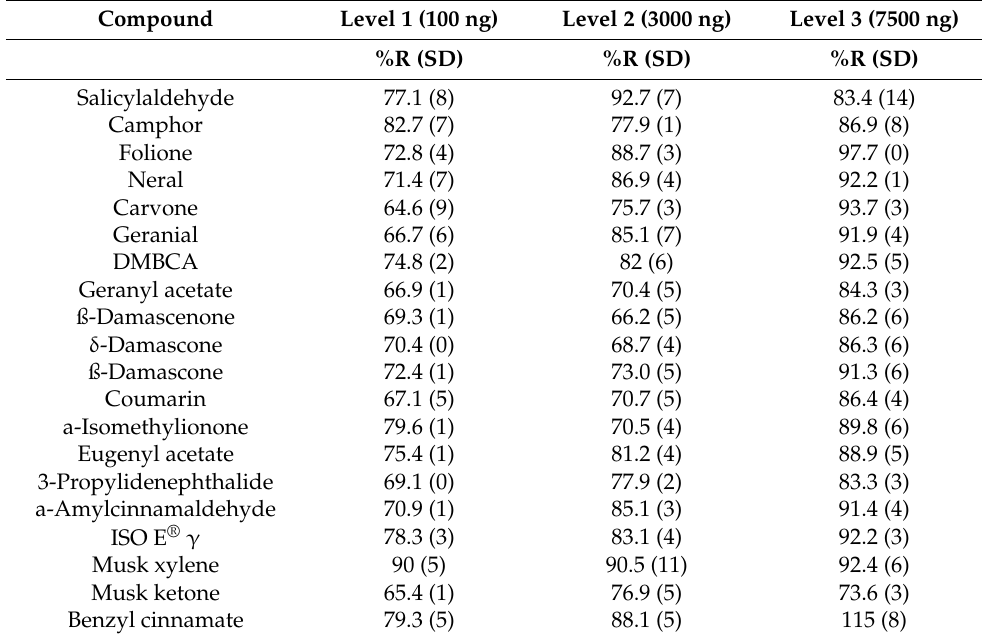
Table 3. Percentage Recovery (%R) and Standard Deviation (SD) of the method at three levels of native